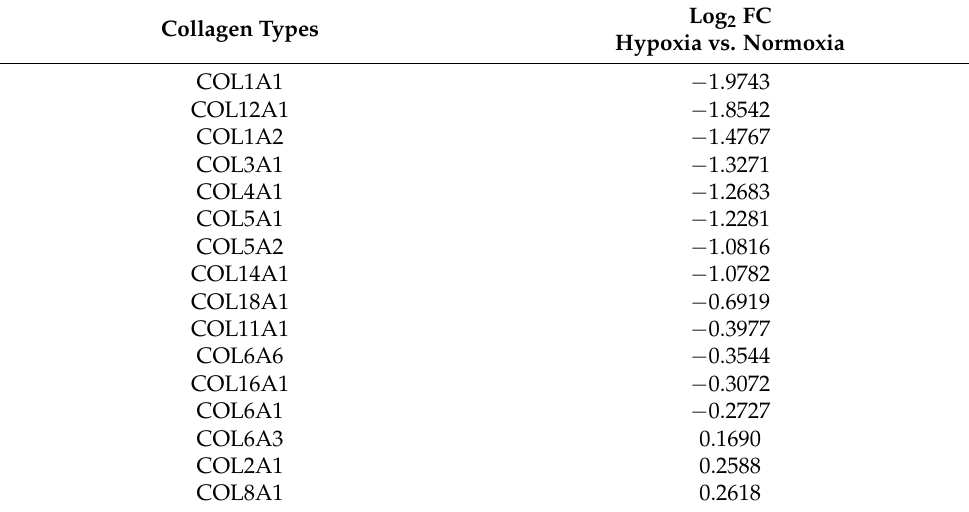
Table 4. Proteomic data outlining the effects of hypoxic incubation on hFPT collagen contents as compared to normoxia incubation, presented for each selected collagen type as the corresponding log 2 FC value. Threshold values for statistical significance determination were specified at − 0.9 for downregulation and at 0.9 for upregulation and an FDR significance threshold value was specified at ≤ 0.01. FC, fold change; FDR, false discovery rate; hFPT, human fetal progenitor